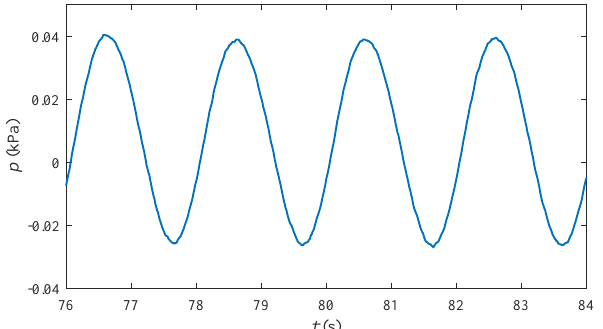
Figure 17. Distribution of pore-water pressures vs time beneath the center of the pile ( x = 0, T = 2.0 s, H = 10 cm, Point